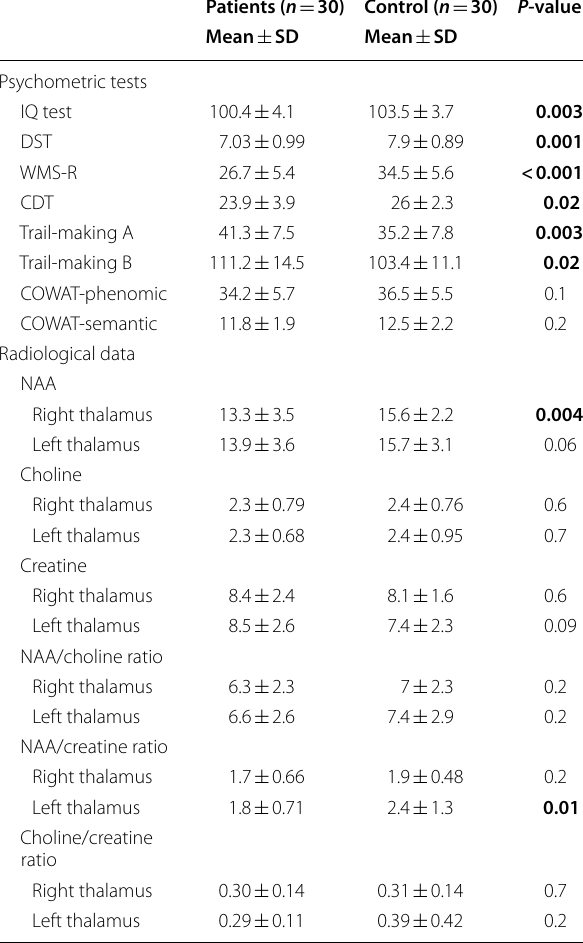
Bold indicates * p < 0.05 is considered